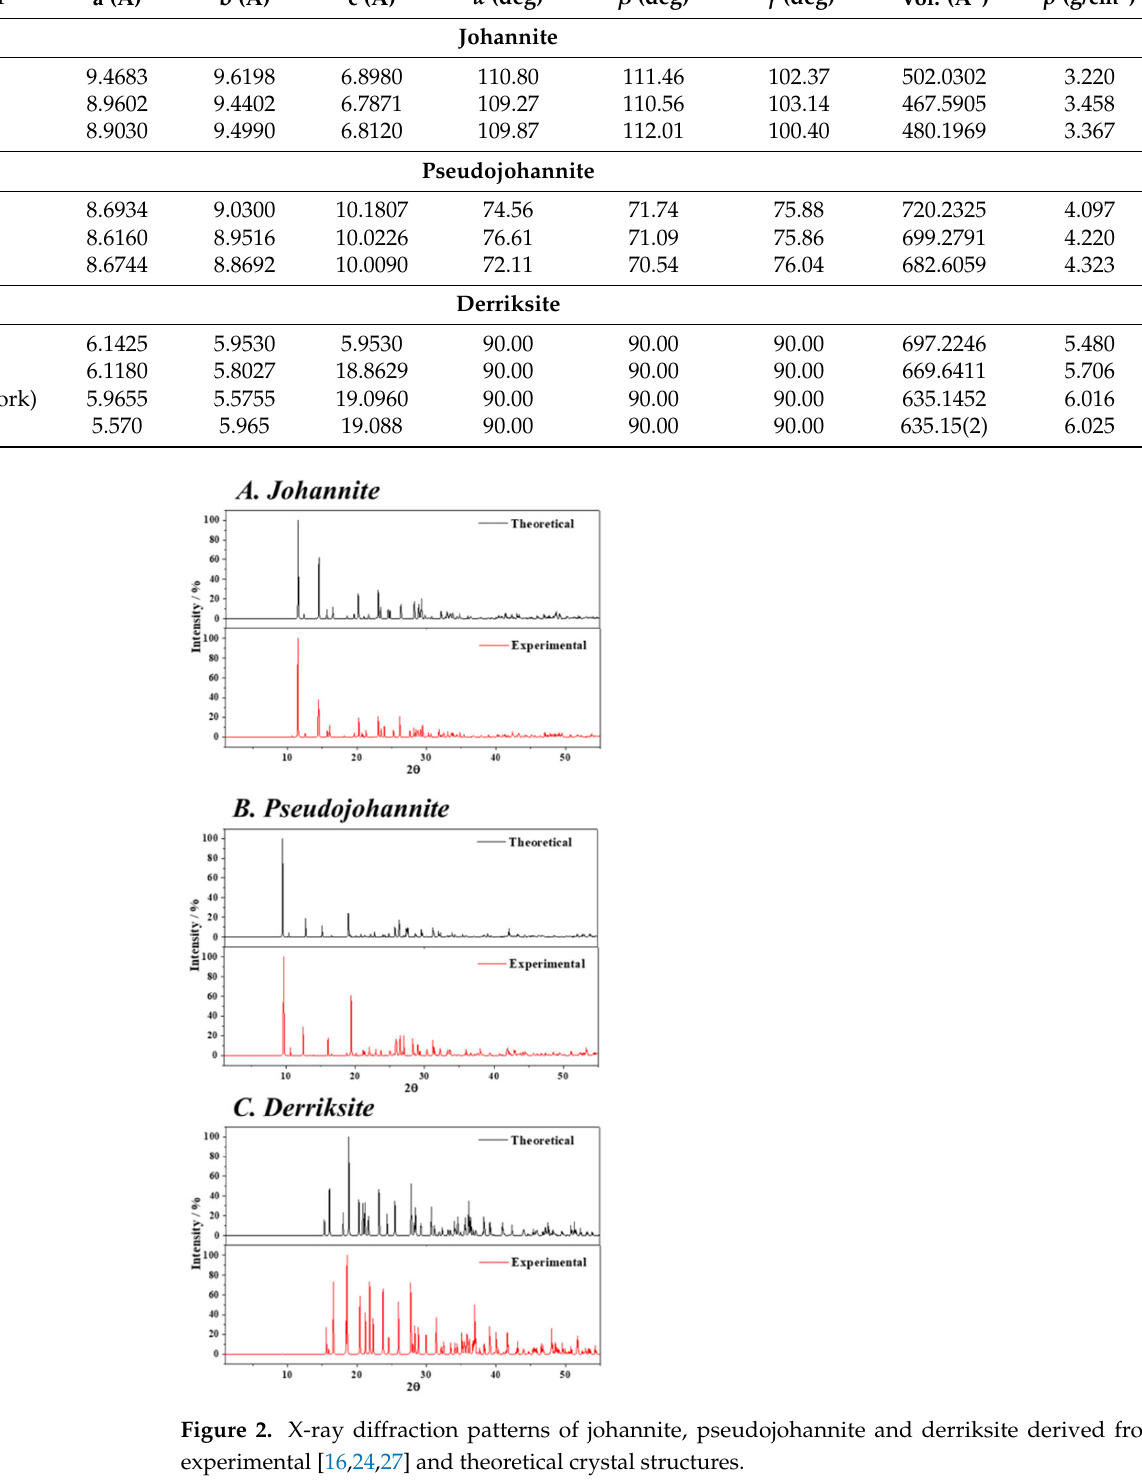
Table 1. Calculated lattice parameters of johannite, pseudojohannite and derriksite minerals. Parameter